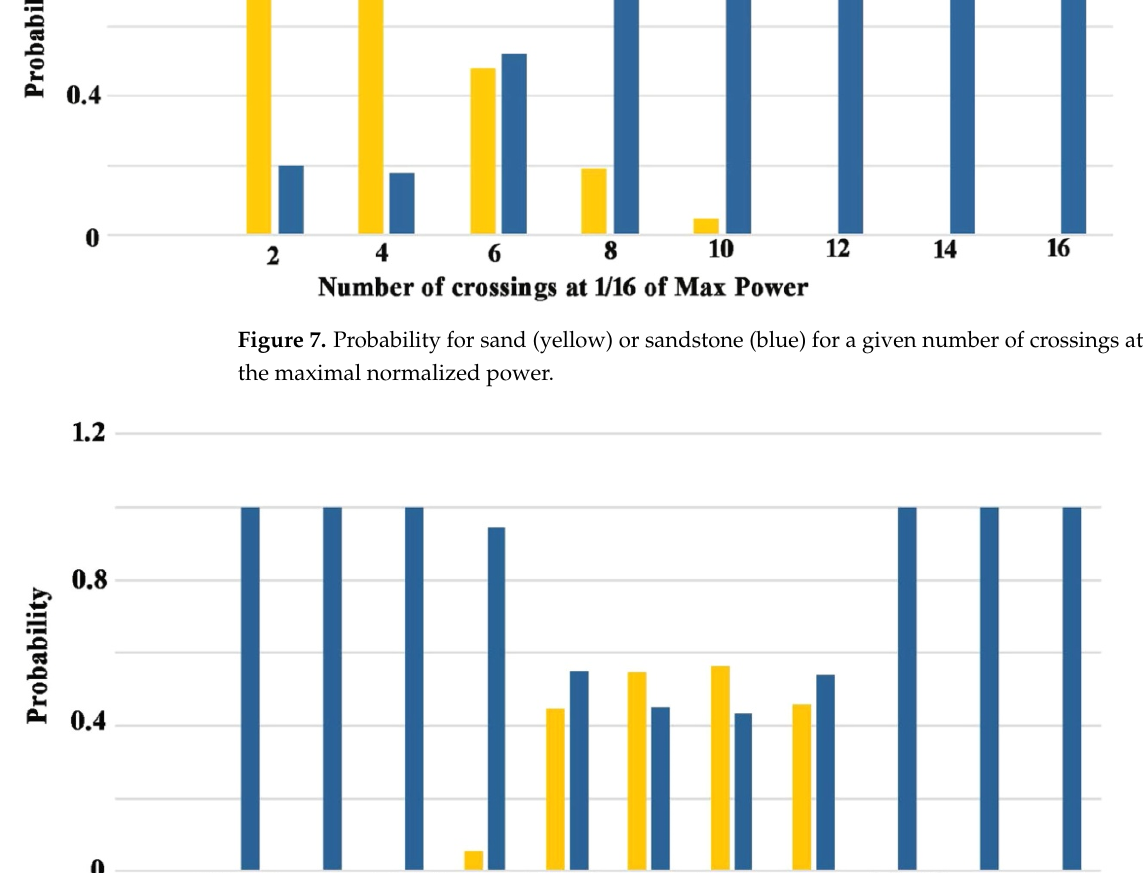
Figure 9. Probability for sand (yellow) or sandstone (blue) for a given range of maximal normalized power.